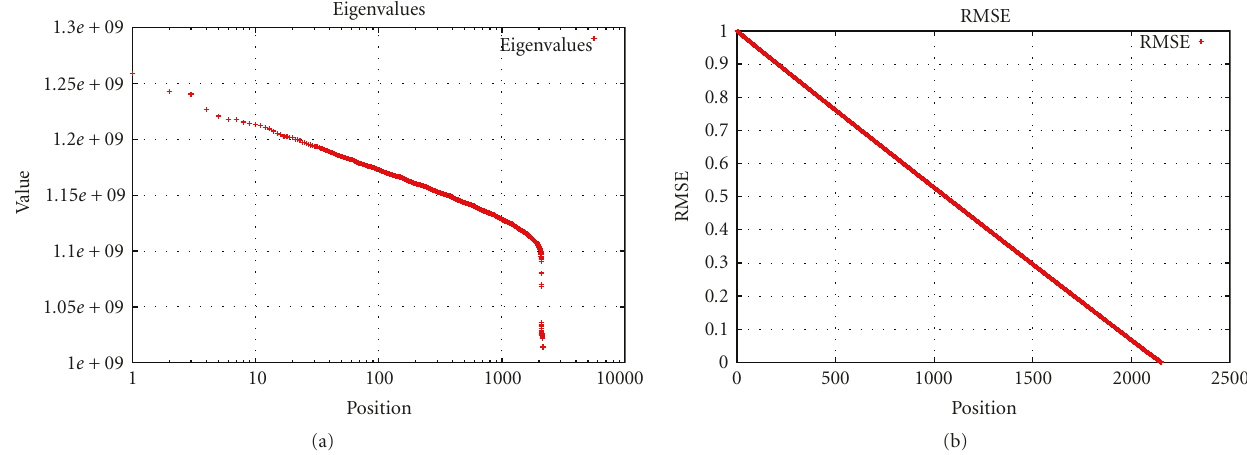
Figure 1: (a) Spectrum of the eigenvalues in the employed generalized PCA representation. Training set of size 2,152. (b) RMSE of the employed